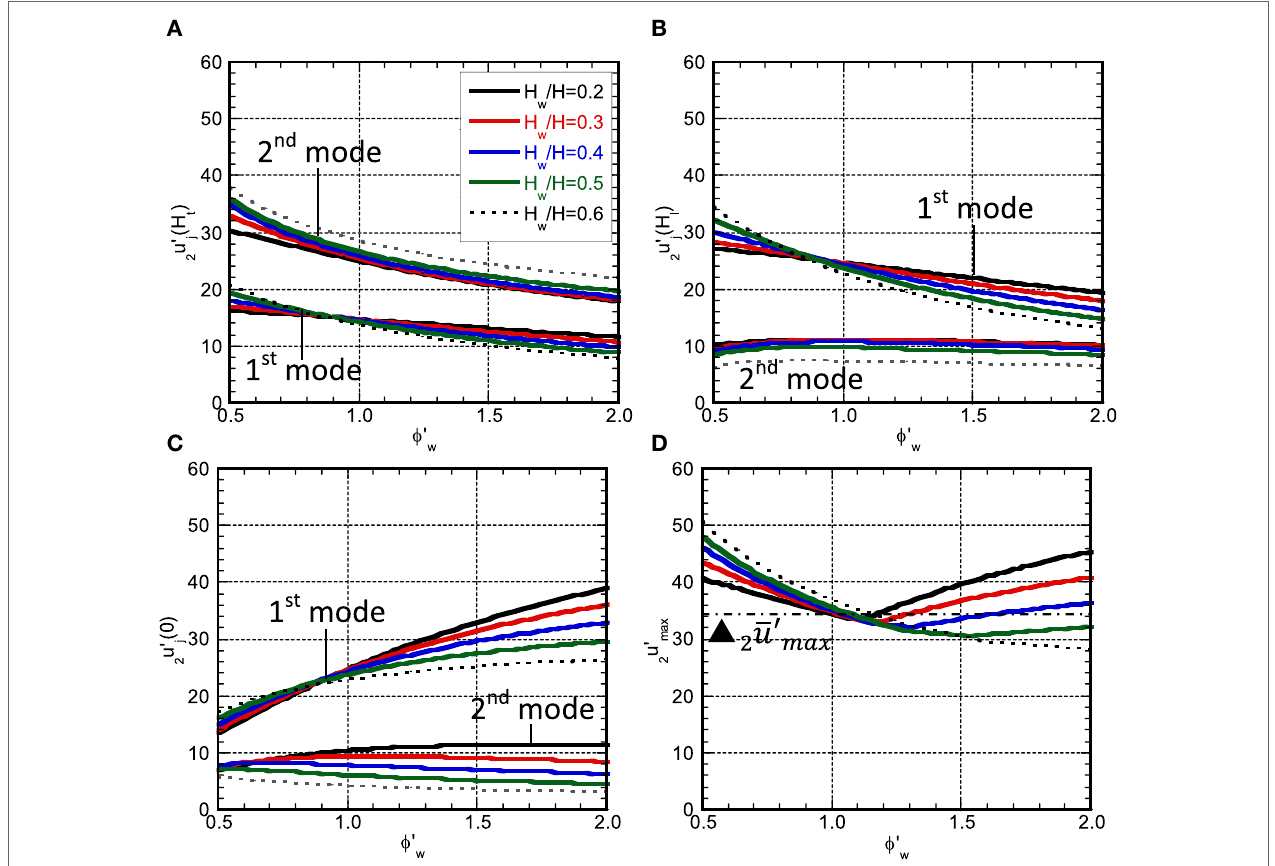
FIGURE 8 | Maximum story drift angle for second-mode resonance pulse: (A) 2 u ′ j ( H t ) , (B) 2 u ′ j ( H l ) , (C) 2 u ′ j ( 0 ) , and (D) 2 u ′ max .